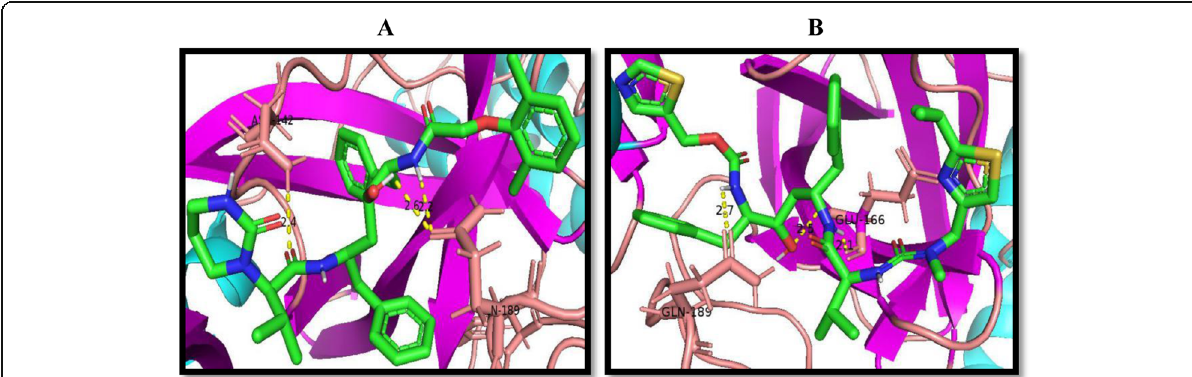
Fig. 12 The polar interaction of lopinavir ( a ) and ritonavir ( b ) when bound to the active site of the downloaded 3D structure of the SARS-CoV main proteinase (6m2n). The compounds are colored predominantly in green (according to elements) for each column and bound to the active site residues displayed in a zoomed ribbon form and colored according to secondary structures (regions of helix, sheets, and coils colored in blue, purple, and brown,